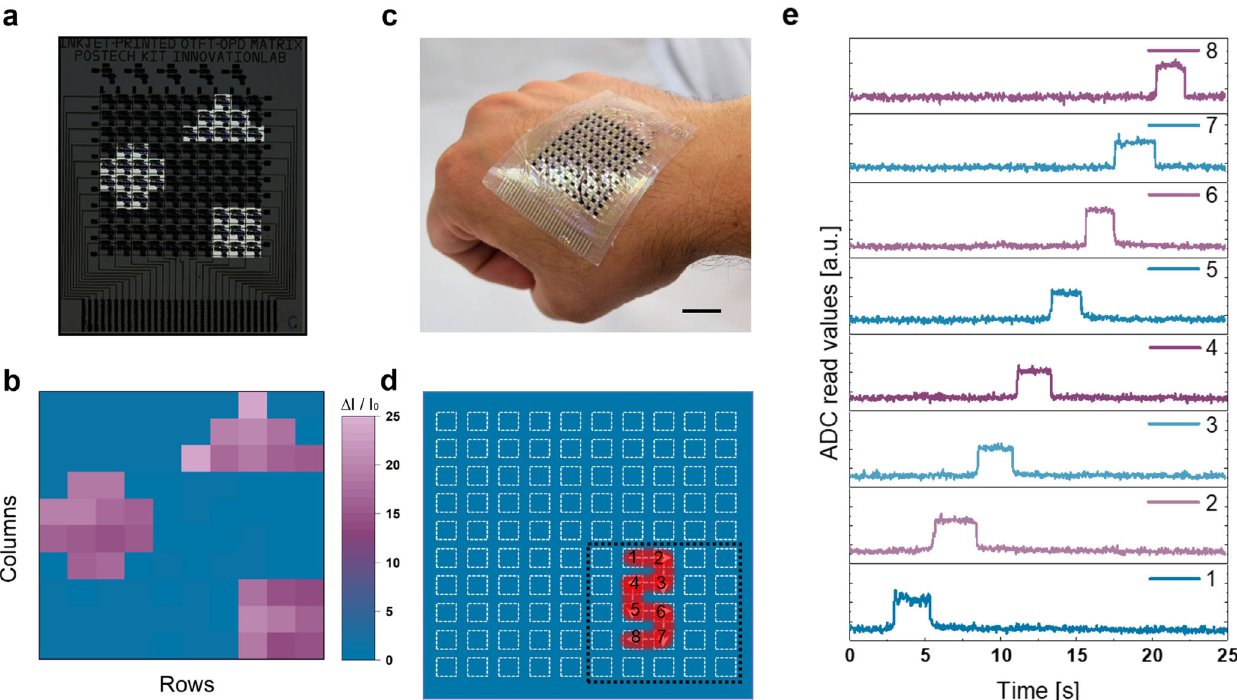
Fig. 6 Active-matrix demonstration. a Photograph of the active matrix covered by a schematic of the patterned mask layout used during the static demonstration measurement. b Mapping of the light response across the 10 × 10 active matrix during static demonstration measurement. The relative change in current is shown for each pixel. Different colors indicate different responses. c Photograph of fl exible active-matrix sample placed on top of a hand (scale bar = 2 cm). d Schematic of the movement of a point light source over the active matrix. The displacement of light forms different patterns. e Real-time current response over the active-matrix while the light was being displaced over the sample. The particular set of data shown here corresponds to the labeled pixels at the bottom-right pattern in Fig. d . The complete set of data is also shown as a video in the supporting